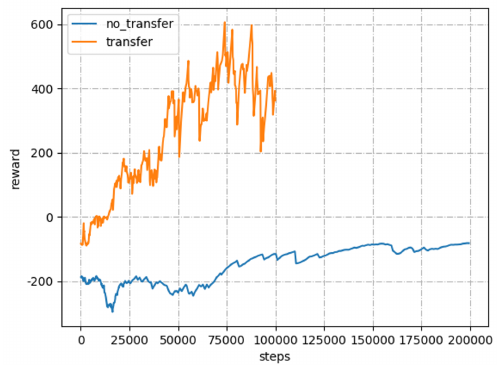
Figure 3. Parameters transfer